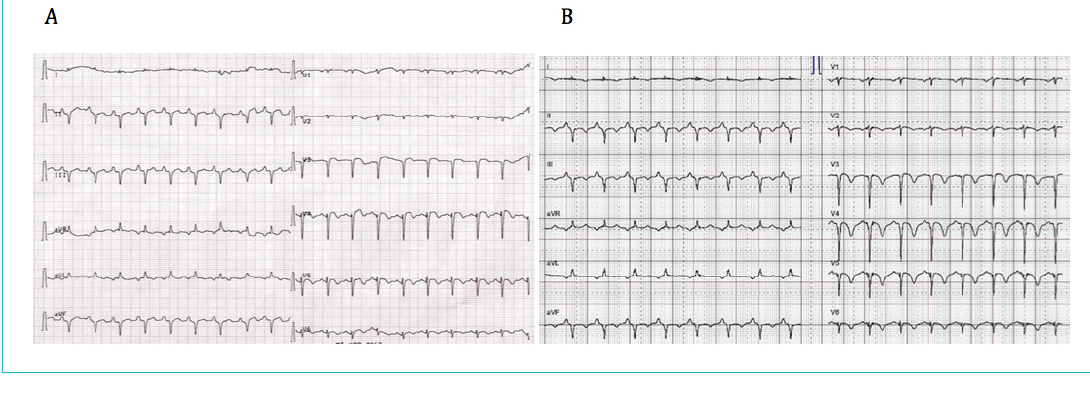
Figure 1: (A) ECG showing diffuse ST segment elevations. (B) Follow-up ECG after 10 hours demonstrates diffuse T wave inversions, particu- larly prominent in V3–V5.